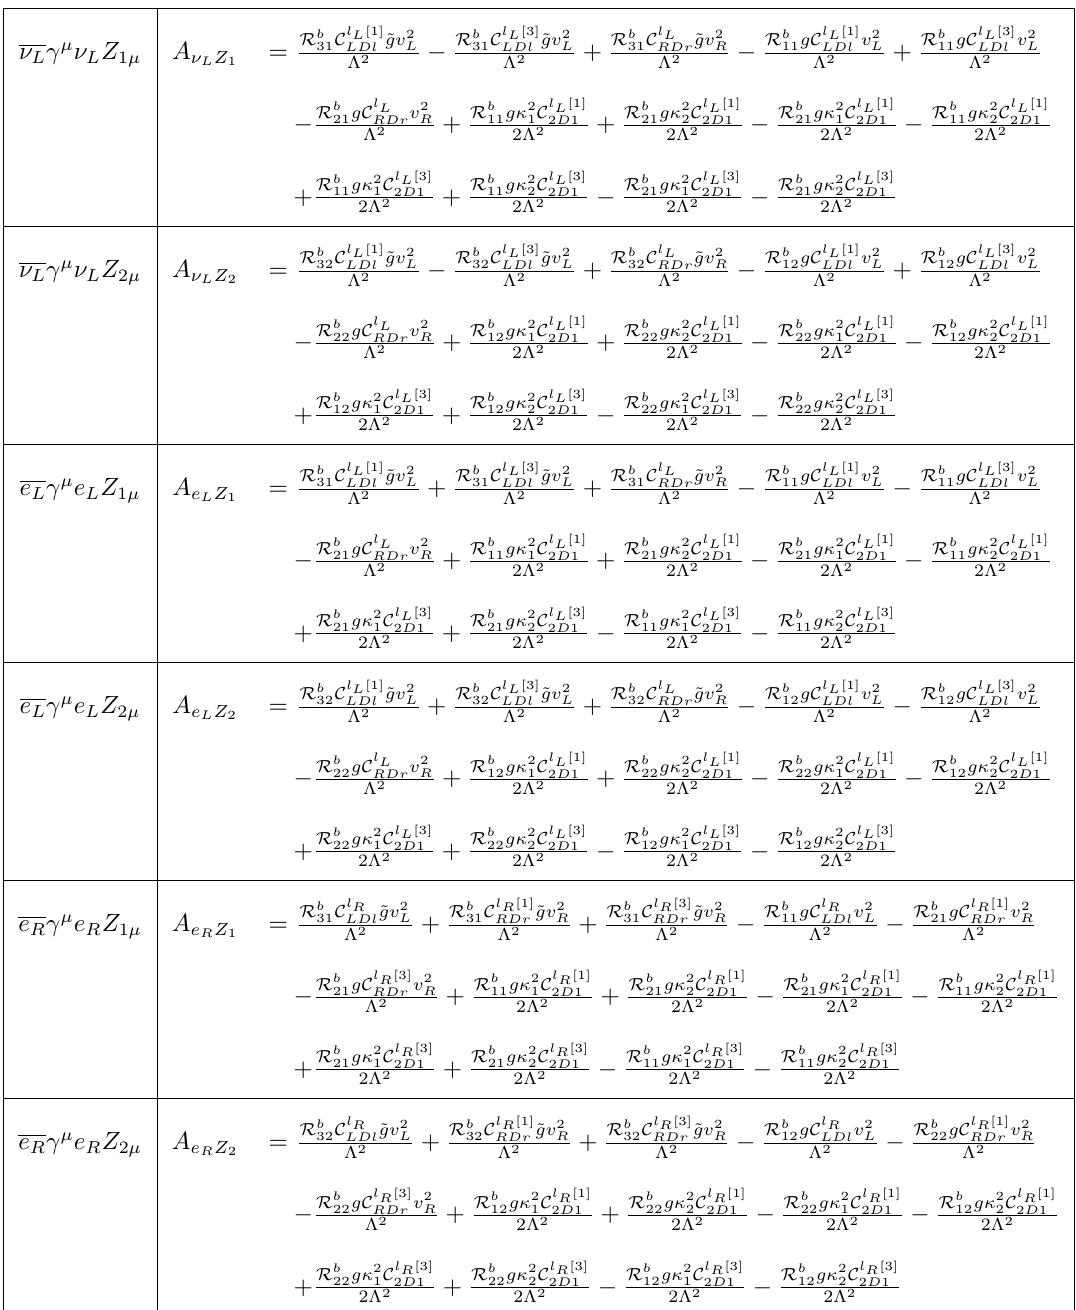
Table 33. MLRSM: corrections to the coupling of neutral gauge bosons and fermions due to 2 (cid:30) 2 D operators.